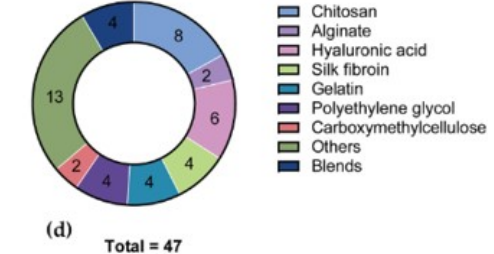
Figure 3. Graphical illustration of the screening process and selected manuscripts. ( a ) General overview of the screening process, including the number of manuscripts removed during identification (i.e., duplicates and those not written in the English language), abstract screening and scoring. Graphical illustration of the final group of selected manuscripts per